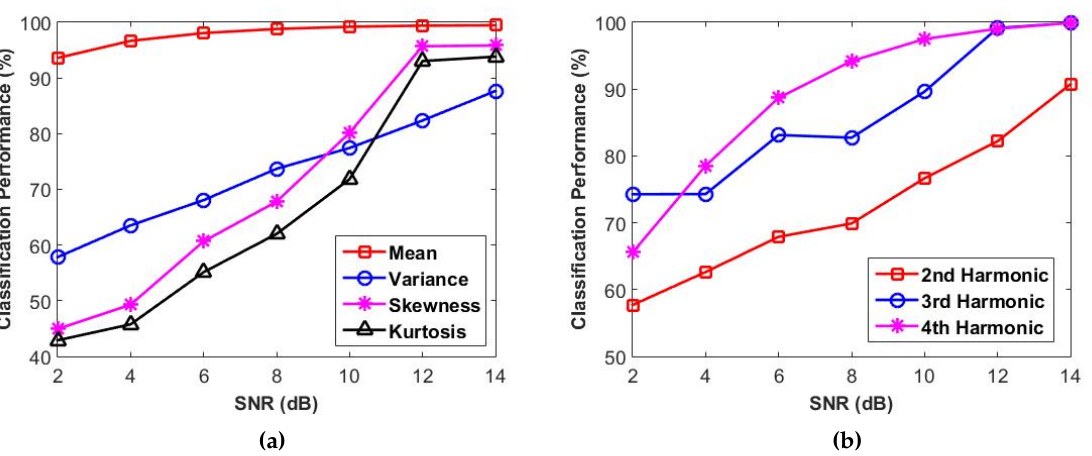
Figure 11. Classification performance presented in [9]: ( a ) Classification performance via statistical features [9] and ( b ) classification performance via each harmonic [9].